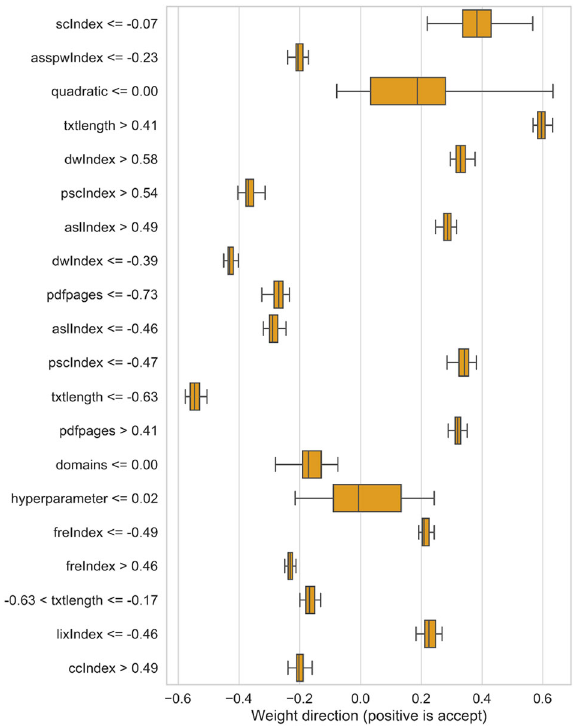
Fig. 9 Distribution of top 20 explanation features for rules covering the training space. Boxplot representing the weight direction for each feature (vertical black line is the median).